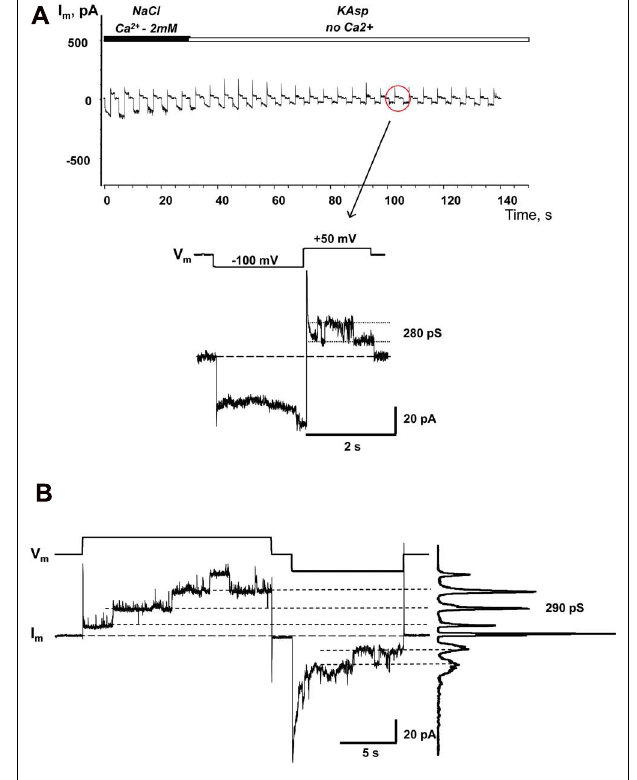
FIGURE 8 | Single hemichannel currents. (A) Current recorded from a HeLaCx26/SpIH cell. Perfusion with the Ca 2 + -free KAsp external solution did not induce a SpIH current increase in four preparations (5.9 ± 1.7 and 6.2 ± 1.9 pA/pF, before and after perfusion, respectively; P = 0.886).The operation of single functioning Cx26 hemichannels was visible throughout the experiment. Insert: segment of current recording on expanded time and current scales shows the opening and closing of a Cx26 hemichannel with a unitary conductance of ∼ 280 pS.The external bath